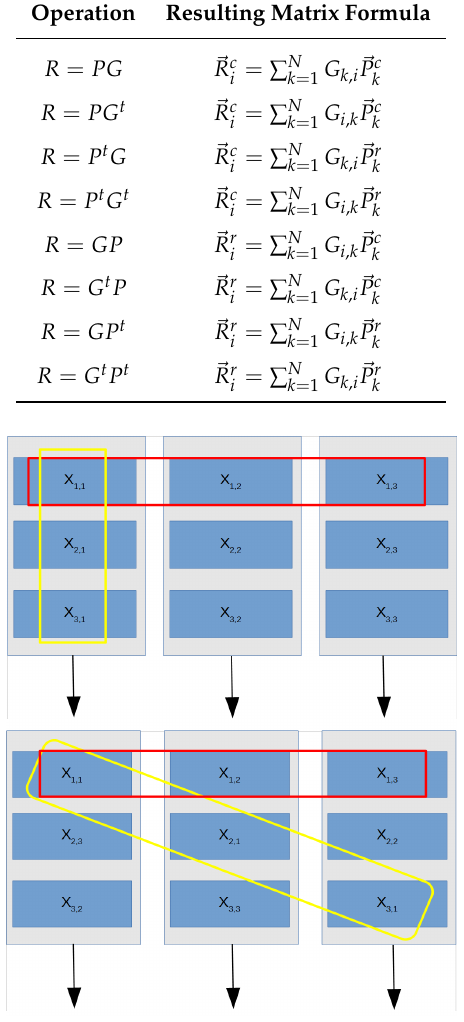
Figure 1. Physical placement of 3 × 3 matrix elements in memory columns in normal (top) and circulant (bottom) forms. Yellow and red marked memory locations represent the first column and the first row of a matrix. Grey blocks are labeled, from left to right, RAM 0 , RAM 1 , RAM 2 , since they correspond to memory blocks in